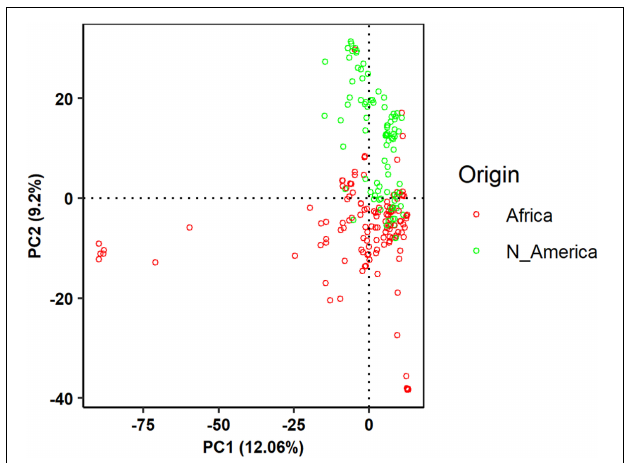
FIGURE 2 | Principal component analysis for common bean genotypes from the Andean diversity panel (ADP) based on the single nucleotide polymorphism (SNP) dataset pruned for the criteria of non-linkage disequilibrium (LD).